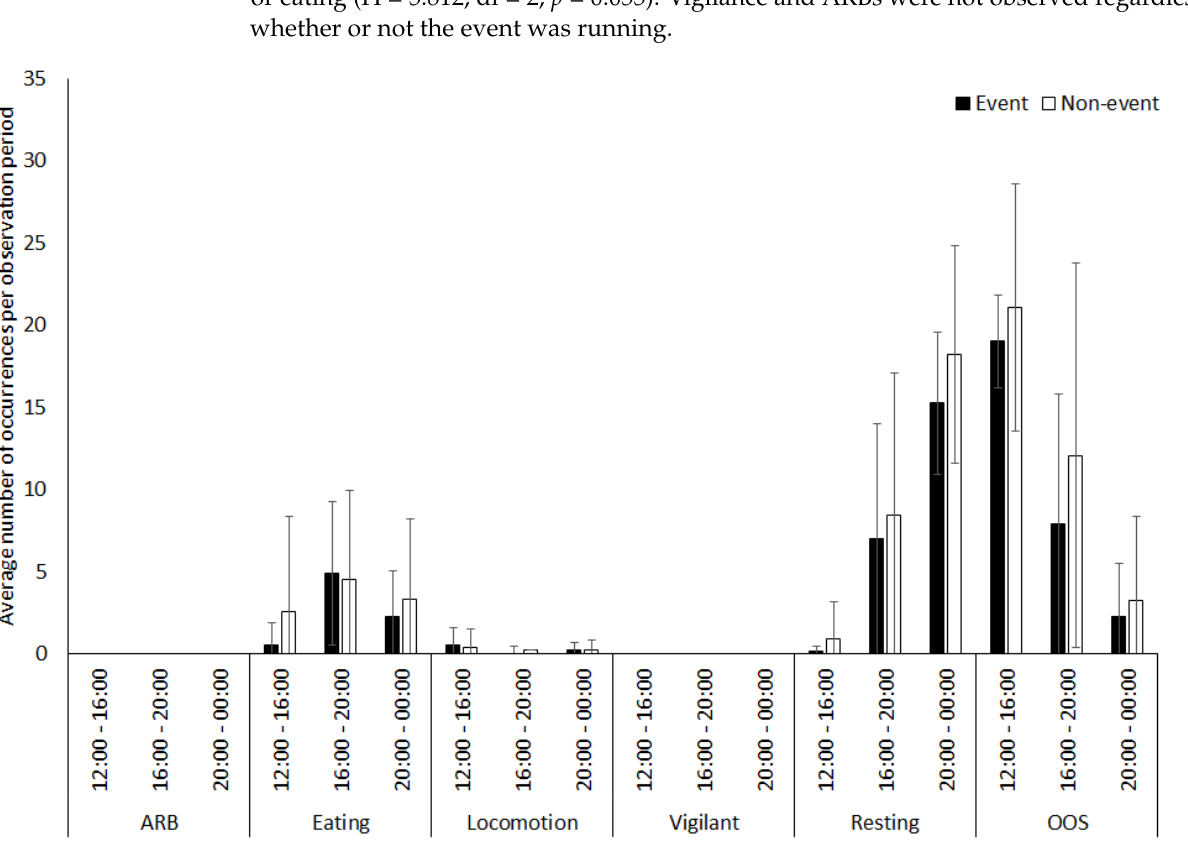
Figure 3. Activity budget data for four capybaras (average number of occurrences of each behaviour within the group per observation period ± standard deviation) from 12:00–00:00 during event nights and non-event nights at Knowsley Safari. Each 12 h was split into three time periods. ARB: abnormal repetitive behaviour, OOS: out of sight of the observer.